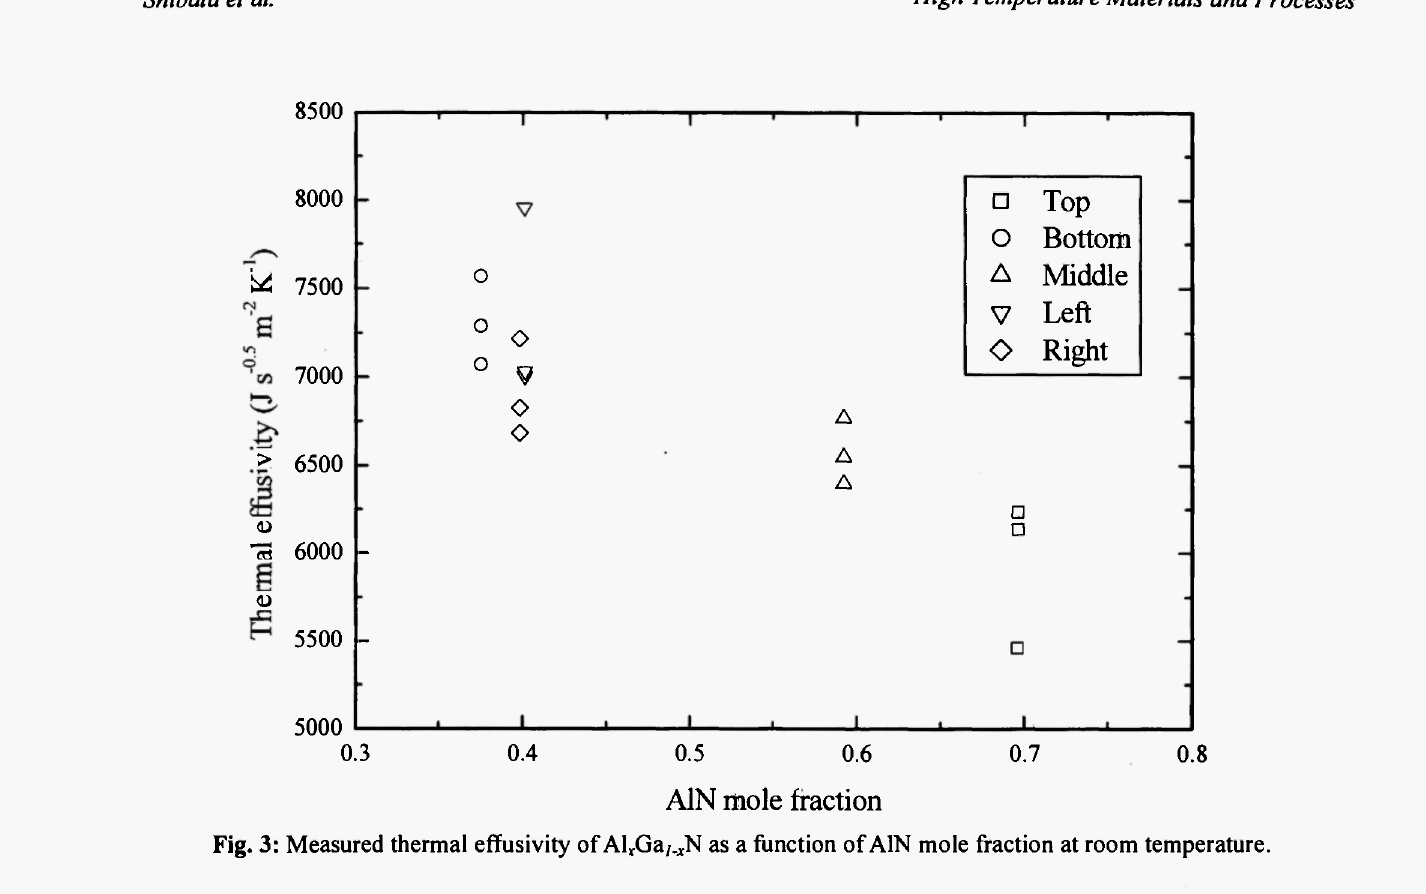
Fig. 3: Measured thermal effusivity of Al r Ga,^N as a function of A1N mole fraction at room